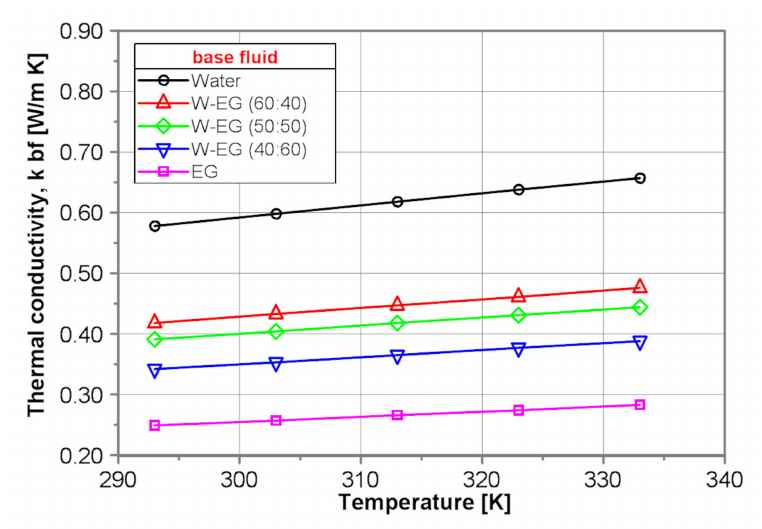
Figure 7. Thermal conductivity of the tested base fluids.